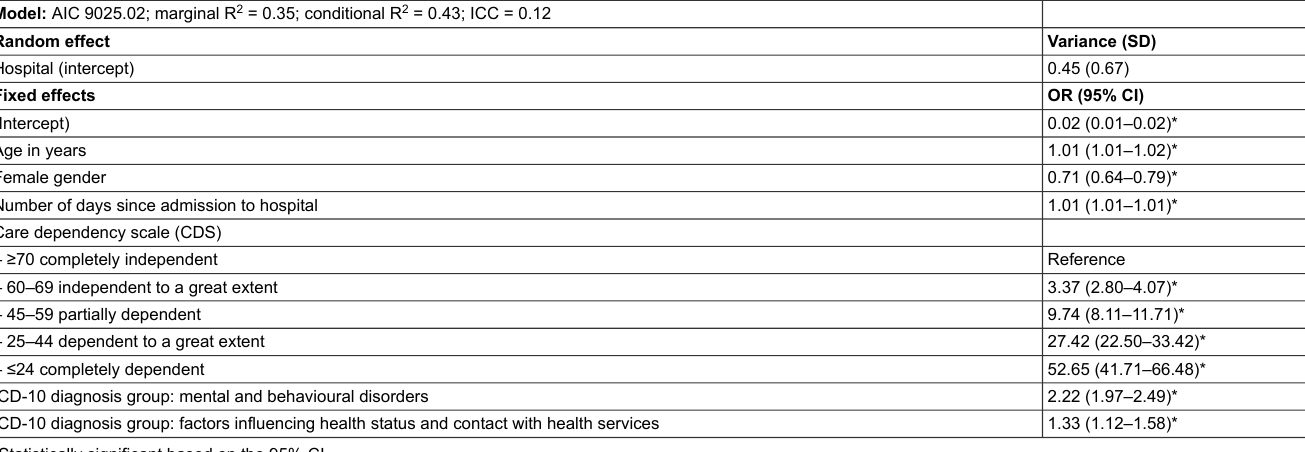
Table 2: Multilevel logistic regression